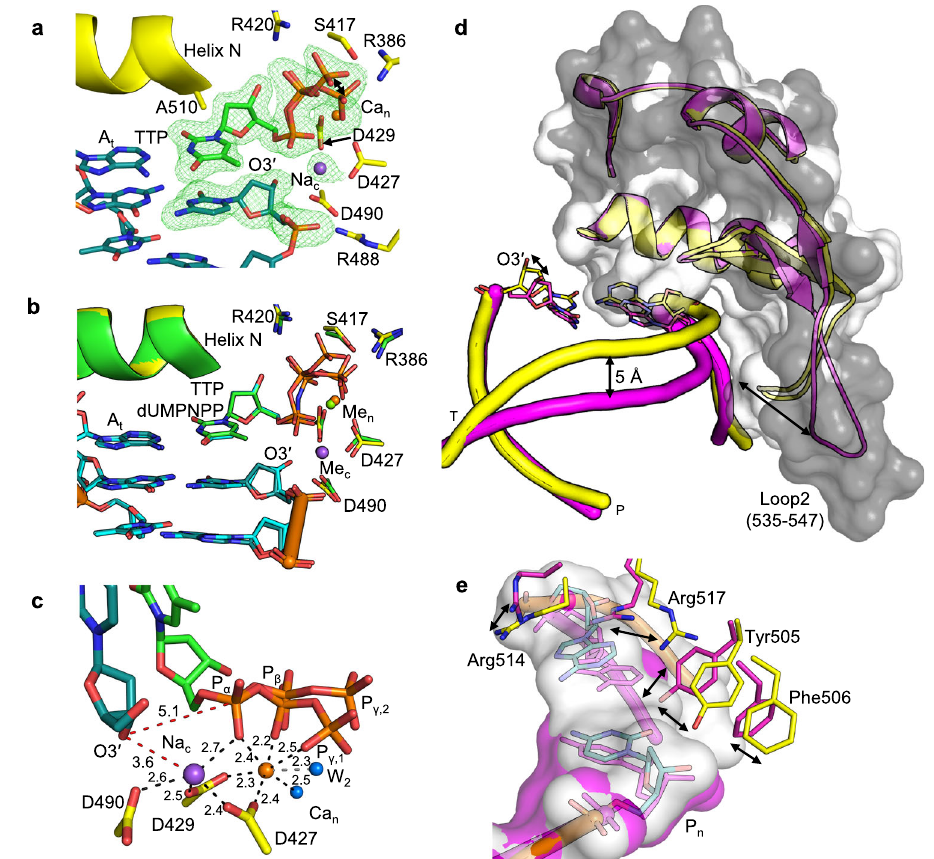
Fig. 1 Matched ground state ternary complex. a Active site of the matched (TTP:A t ) Ca 2 + -ground state (GS) ternary complex. Incoming thymidine 5 ′ - triphosphate (TTP) opposite template deoxyadenosine (A t ) is displayed in green stick representation, DNA in cyan, active site residues in yellow. Ca 2 + bound to the nucleotide metal site (Ca n ) is shown as an orange sphere, catalytic Na + (Na c ) is a purple sphere. Dynamics in the position of P γ (of TTP) is indicated with a black double-headed arrow. Simulated annealing omit (F o -F c ) density (green mesh) is contoured at 3 σ , carve radius 2.0 Å. b Structural overlay of the matched Ca 2 + -GS ternary complex and a pre-catalytic ternary complex (PDB id 2PFO 18 , protein green, DNA light cyan) bound to a non- hydrolyzable nucleotide (dUMPNPP, light cyan). Mg 2 + is shown as a green sphere. c Active site metal coordination (Å, black dashes) and key distances (Å, red dashes) in the Ca 2 + -GS complex. The view shown is a ~90° rotation of that in panel ( a ). Distance of O3 ′ from both P α and Na c is shown with red dashes. Coordination of Ca n with an alternate water (W 2 ), when P γ ,2 interacts with Arg420 (see Supplementary Fig. 1a), is shown with a grey dashed line. d Template strand shift in the matched Ca 2 + -GS ternary complex (yellow cartoon). Overlay with the structure of a pol λ -DNA binary complex (magenta cartoon, PDB id 1XSL 12 ) is shown. A shift in loop 2 (Ala535 to Pro547) to contact the downstream template strand is observed upon TTP binding. Differences in atomic positions are shown with double-headed arrows. Atomic volume is shown in light and dark gray surface representation for the Ca 2 + - GS and binary complex, respectively. e Shifts in “ steric gate ” (Tyr505 and Phe506) and active site arginine residues (Arg514 and Arg517) upon ternary complex formation. Color schemes are as described above. Atomic volume is displayed as a light gray surface for the GS complex and in magenta for the binary complex. The template strand shift and associated changes in active site residues are shown with double-headed